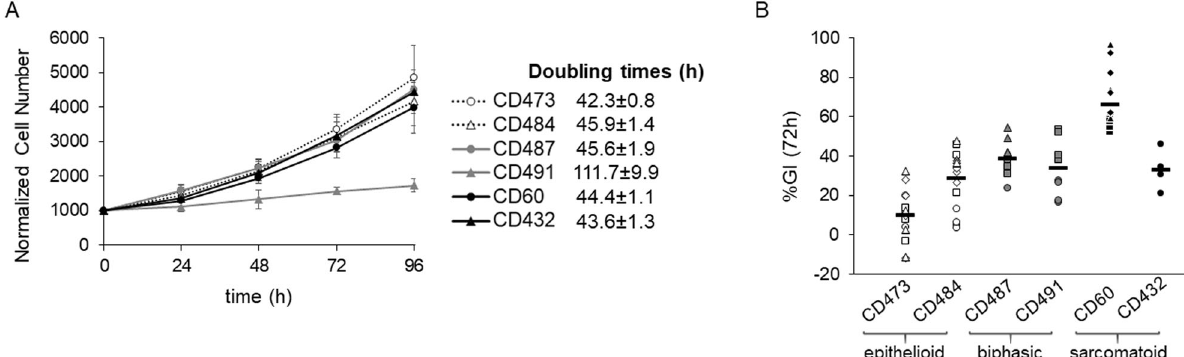
Fig. 1 Cell growth in control conditions and TTTFields antiproliferative effect. A Growth curves of MPM cell lines in normal culture conditions. Cell growth was monitored by counting the cells with a Coulter Counter every 24 h for 4 days. Each symbol represents the mean of at least four technical replicates of two independent experiments with its standard deviations. Calculated doubling times are shown by the respective cell line. B Growth inhibitory effects at 72 h of treatment (%GI (72 h)), calculated as the ratio of the growth rate of treated to control samples. Each symbol represents one replicate, while different symbols in the same data set are used to identify independent biological repeated experiments. Black lines represent the mean value of each data